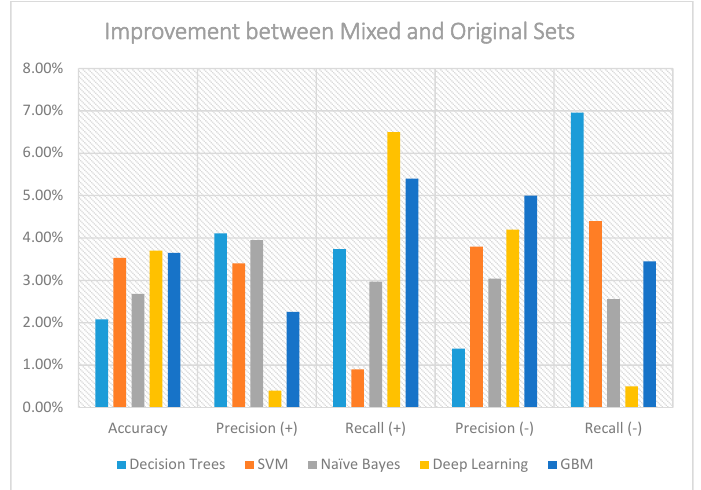
Figure 3. Improvement when considering the mixed dataset, in terms of accuracy, precision and recall per each class label, over the original dataset.